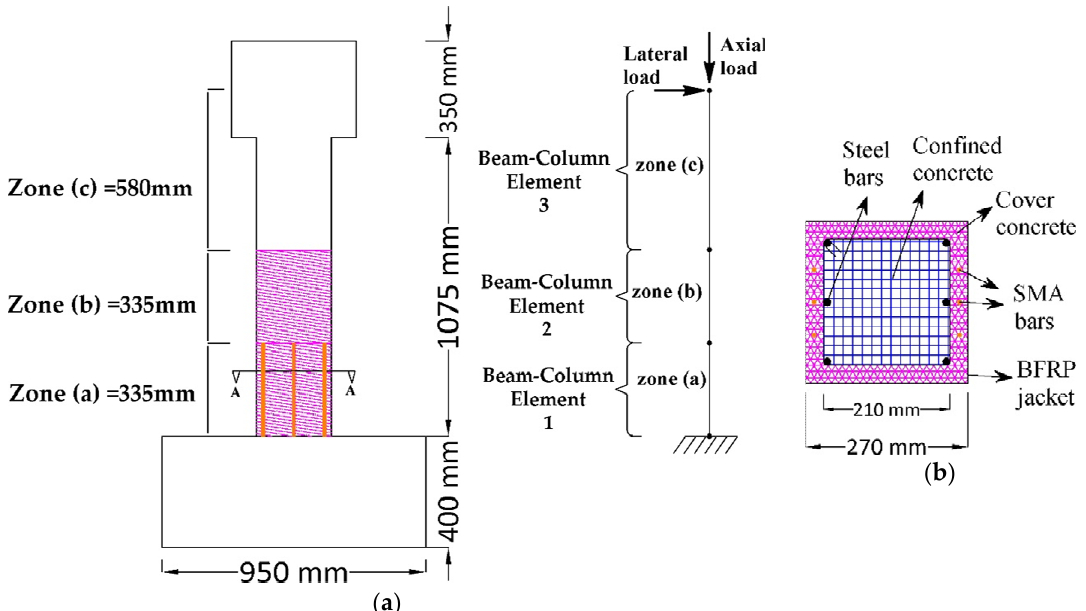
Figure 5. ( a ) Schematic of the column in Group2 and its numerical model; ( b ) fiber discretization of the retrofitted column in Group2.